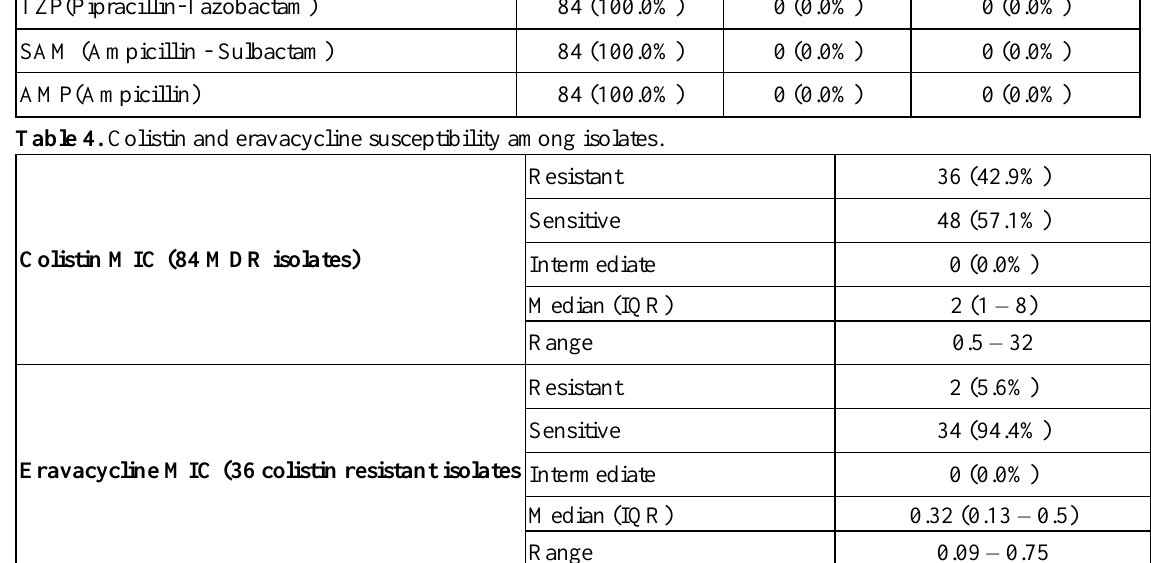
Table 4. Colistin and eravacycline susceptibility among isolates.